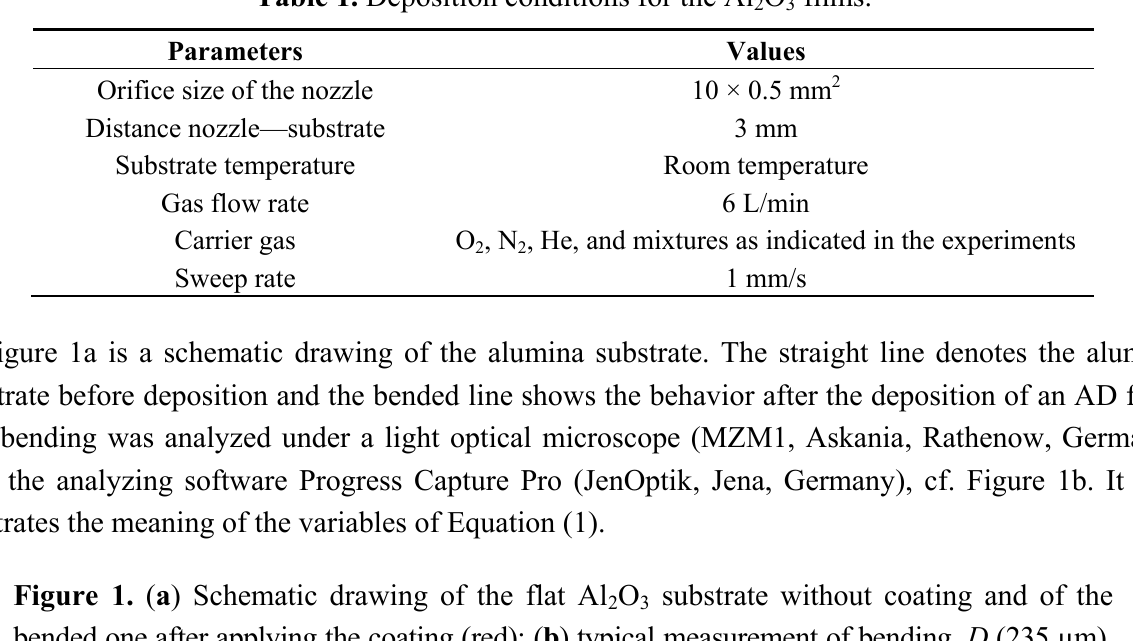
Table 1. Deposition conditions for the Al